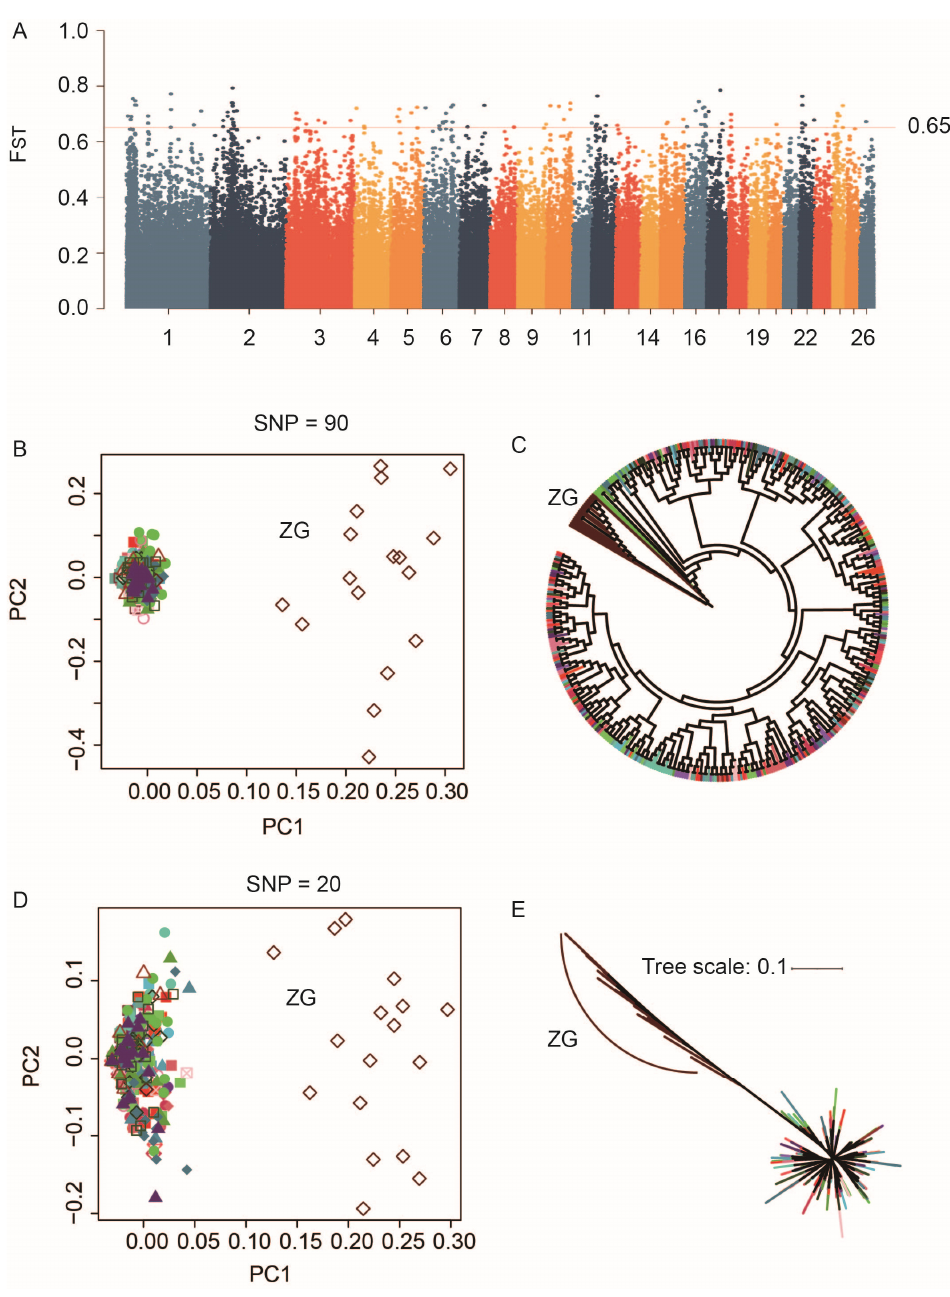
Figure 5. Construction of specific SNP genetic marker sets in Zuogong (ZG) Tibetan sheep. ( A ) Genome-wide distribution of FST values in Yunnan–Tibetan sheep (Jianchuan, JC, and Ninglang, NL, sheep). The significance threshold of the selection signature was set to 0.65 for each individual test and is indicated with red horizontal full lines. ( B ) PCA and ( C ) NJ tree analysis of 90 SNPs distinguishing Zuogong (ZG) sheep. ( D ) PCA and ( E ) NJ tree analysis of 20 SNPs distinguishing Zuogong (ZG) sheep. The dark red hollow rhombus represents ZG sheep in the PCA plots. The color of ZG sheep in the NJ tree was as the same as that in the PCA plots.